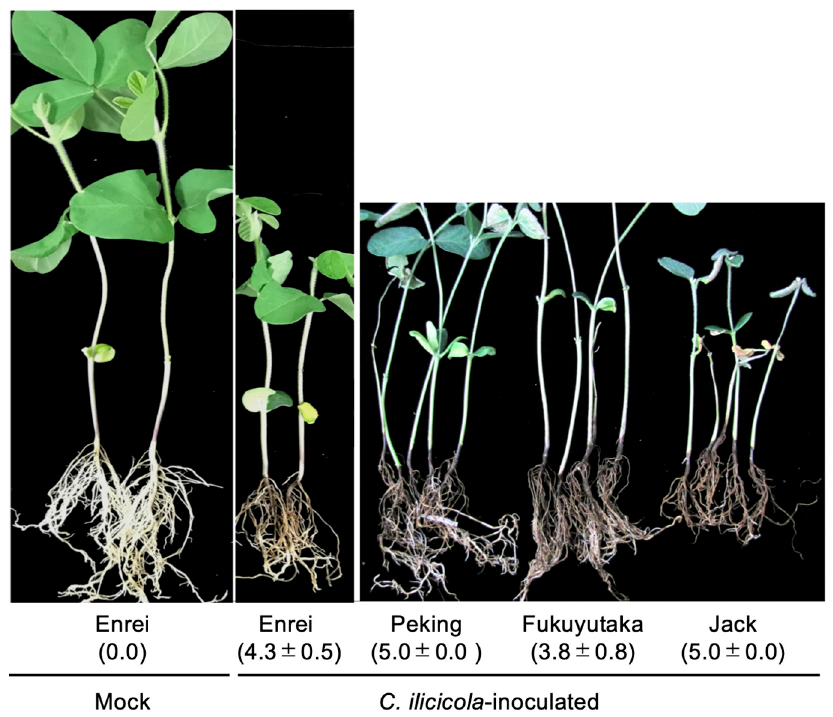
Figure 2. Incidence of red crown rot in four elite soybean cultivars. The photograph was taken 14 days after inoculation with Calonectria ilicicola (UH2-1, 1%). Mock plants (Enrei) were grown without C. ilicicola -inoculation. The visual rating scores of red crown rot (RCR) severity are shown in parentheses (means ± SD, n = 3 replicates of 5 individuals each).